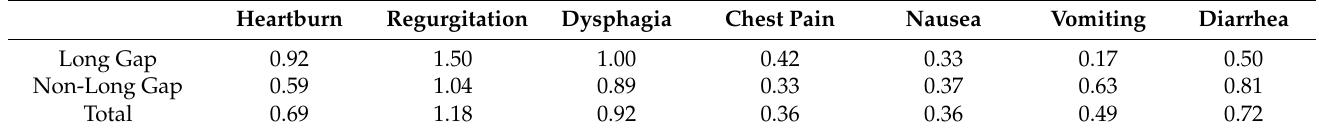
Table 3. Score of gastrointestinal